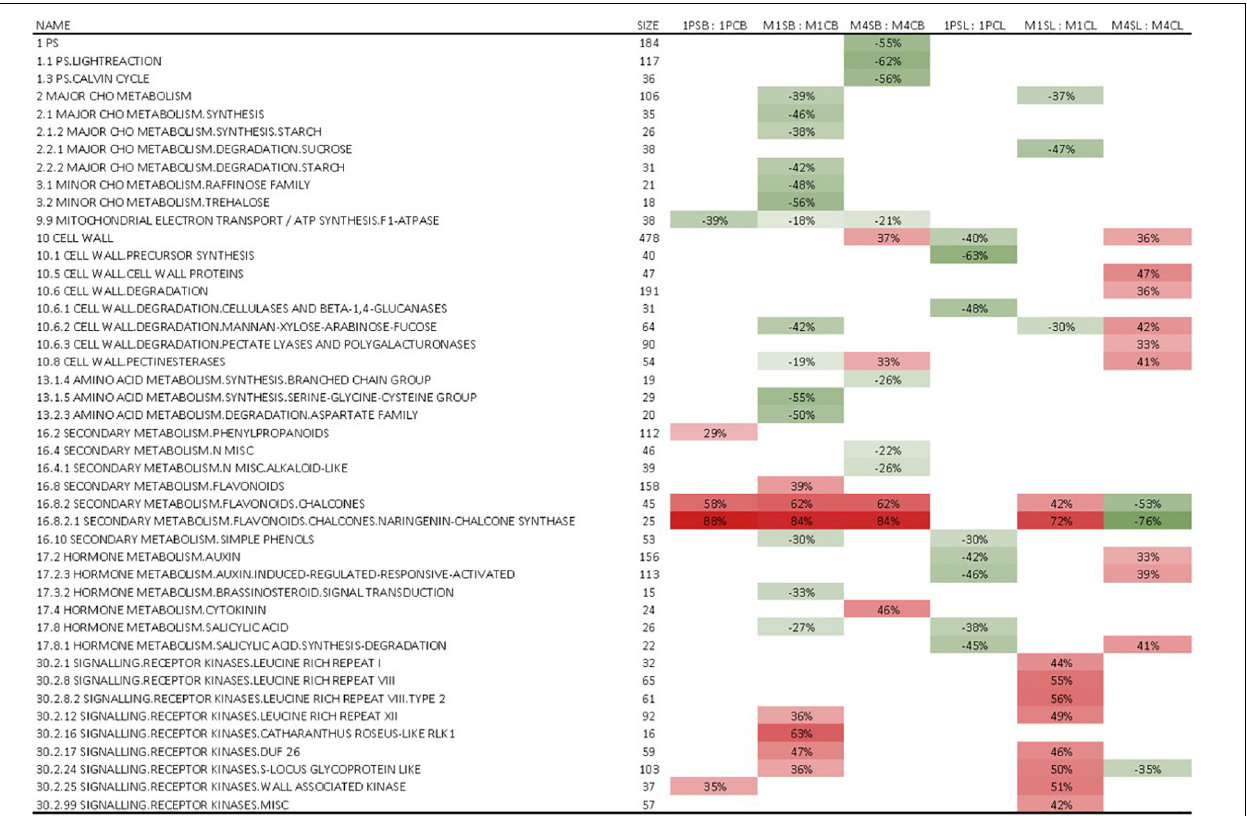
FIGURE 3 | A subset of significantly enriched gene sets obtained by GSEA (The full set is presented in Supplementary Table 2 ). Values represent the percentages of genes that were positively (+) or negatively (–) regulated within a particular bin in leaves and berries of cv. ‘Tempranillo’ vines grafted onto 1103-Paulsen, M1, or